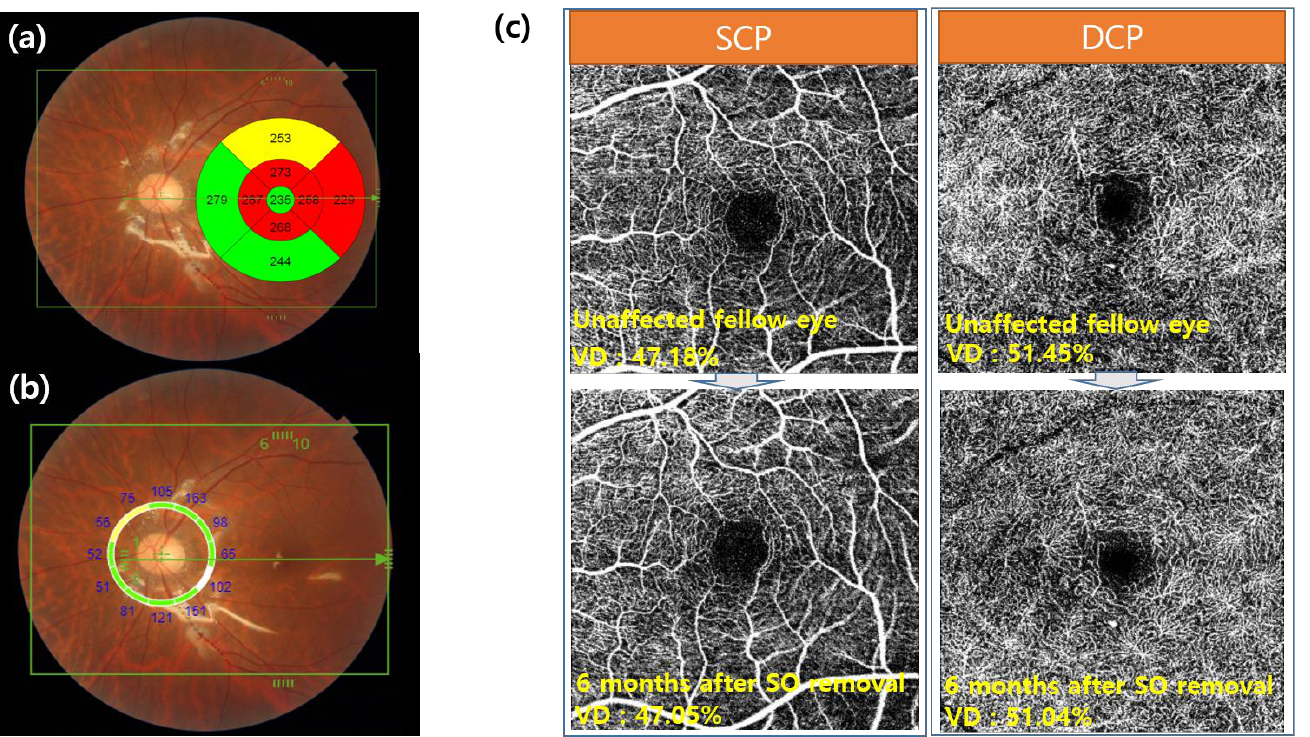
Figure 1. Representative images of this study. ( a ) ETDRS retinal thickness and ( b ) peripapillary retinal nerve fiber layer (ppRNFL) thickness were measured simultaneously using the SS-OCT 3D volumetric wide scan mode (12 × 9 mm) in the silicone oil tamponade state. ( a ) ETDRS retinal thickness can be created to illustrate the thickness deviation (from normative data) within a 6 × 6 mm ETDRS map, using a color-coded scale. The ETDRS map is centered on the fovea. Yellow pixels (representing a thickness <5% of the normative level) or red pixels (representing a thickness <1%), indicating retinal thinning, were considered abnormal in our analyses. It can be seen that the thickness of the parafovea region (inner circle) is relatively thin. ( c ) Vessel density was taken from unaffected fellow eyes and eyes at six months after SO removal using SS-OCT angiography (4.5 × 4.5 mm). There are no significant changes compared with the unaffected fellow eye. SCP: superficial capillary plexus, DCP: deep capillary plexus, SO: silicone oil, VD: vessel density.